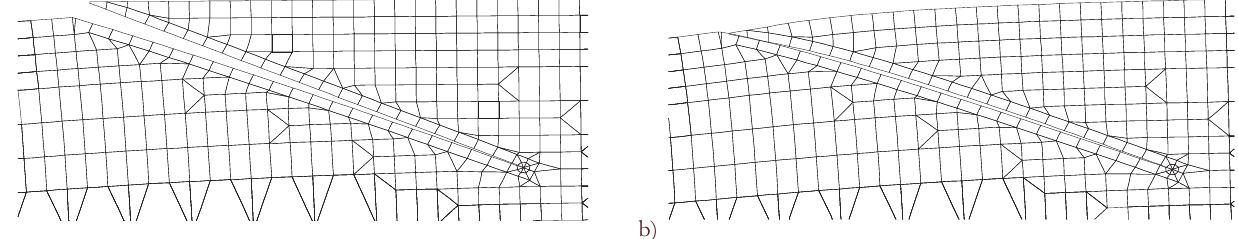
Figure 2: Part of a deformed FEM mesh representing the prism with the crack for two positions of the cylinder: a) x/b = -1.2 – corresponding to the maximum crack opening; b) x/b = -0.9 - corresponding to the position at which the crack mouth is closed